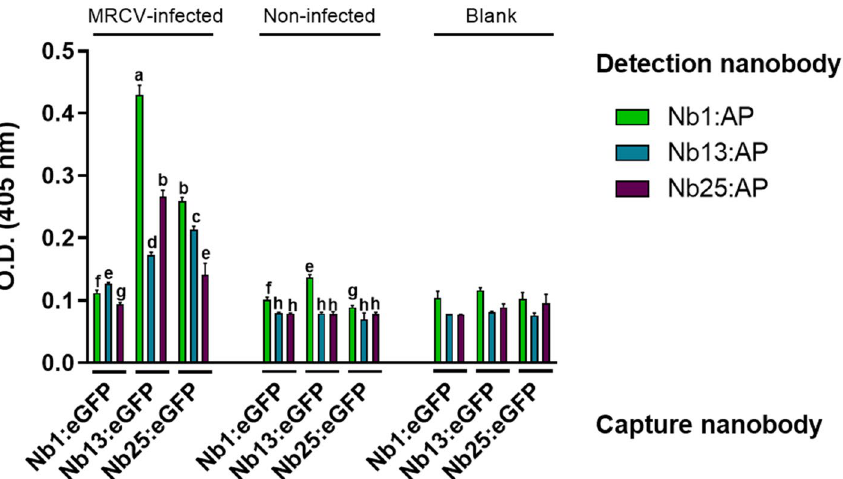
Figure 1. Definition of the best capturing-detection Nb combination for sandwich ELISA. Three different Nbs were independently used as capturing Nb fused to eGFP (Nb:eGFP), and as detecting Nb fused to alkaline phosphatase (Nb:AP), in all possible combinations. Wells were coated with 100 µl of 5 ng/µl of Nb:eGFP, incubated with 100 µl of 0.5 ng/µl of Nb:AP and detected with 100 µl of 1 mg/ml of pNPP. ANOVA followed by Tukey’s multiple comparison test was performed. Bars denoted by the same letter are not statistically significant (p >